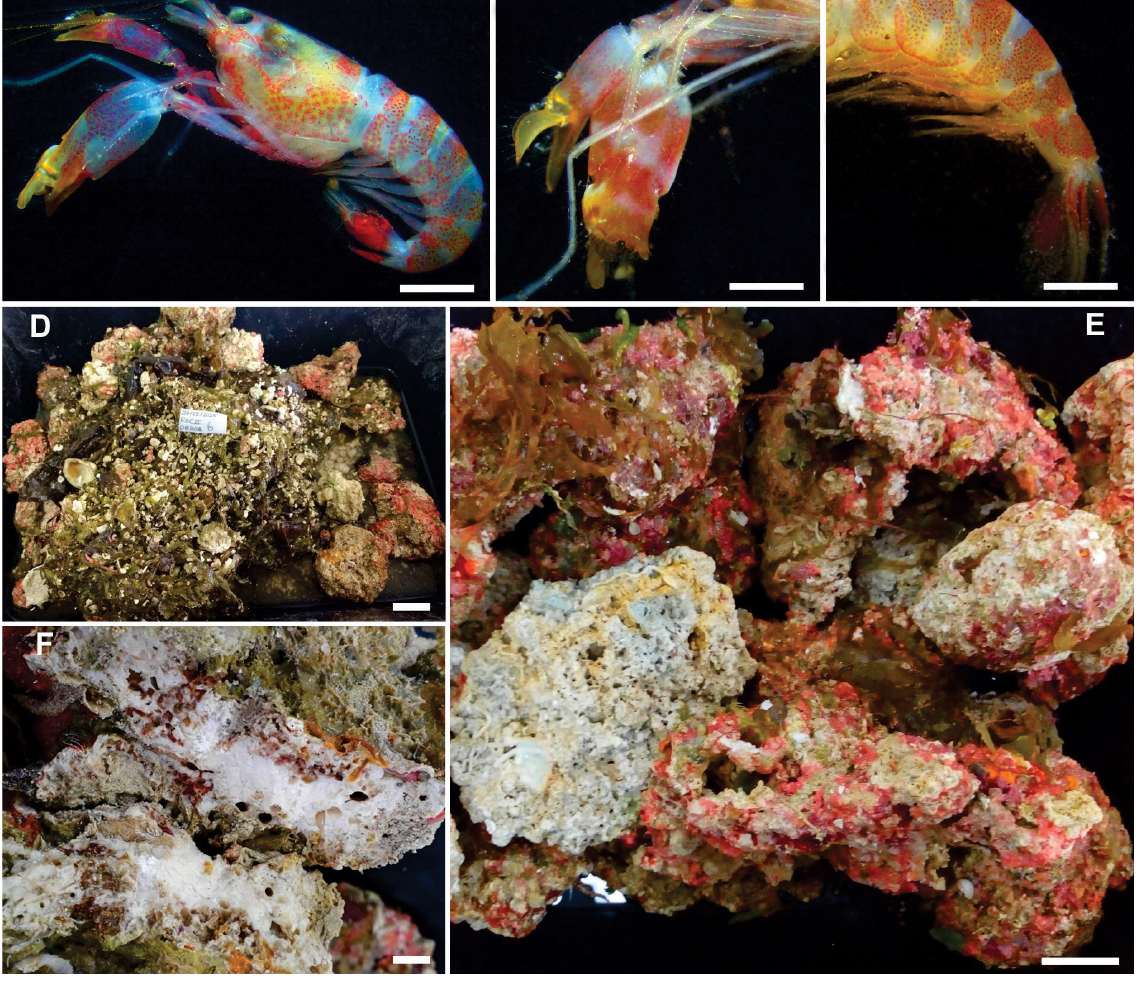
Fig. 4. Alpheus ramosportoae sp. nov. from off Recife, state of Pernambuco, northeastern Brazil. A–C . Color pattern in life of the species. A . Body color pattern, lateral view. B . Coloration of major (mesial view) and minor (lateral view) chelipeds. C . Coloration of pleon, lateral view. D–F .